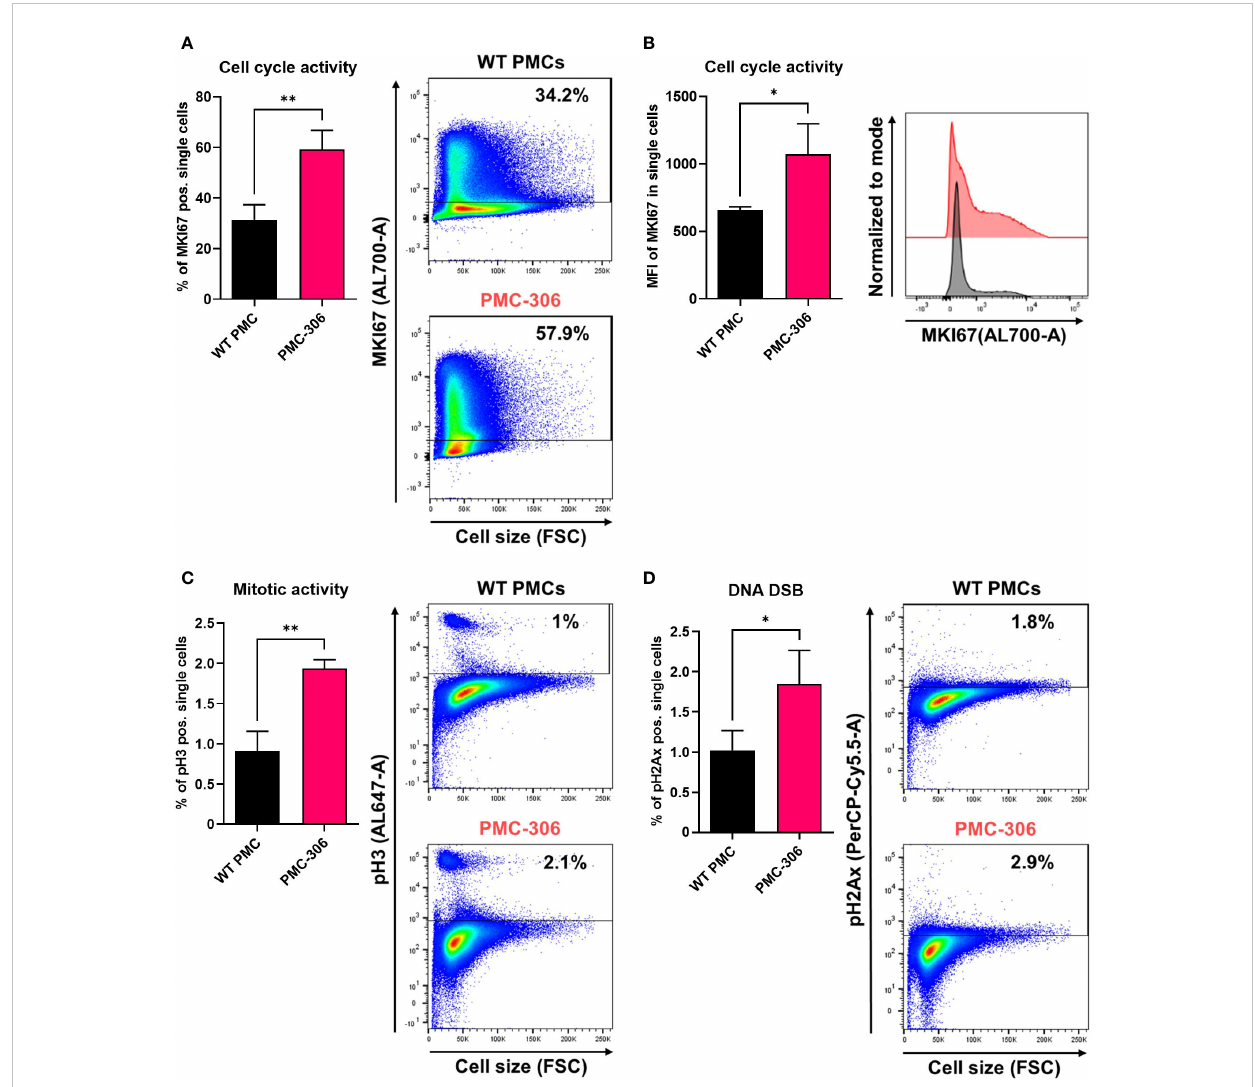
FIGURE 7 PMC-306 cells are characterized by enhanced cell cycle activity and sporadic DNA damage. The cell cycle of primary WT PMCs was compared to PMC-306 cells. (A) Cells were stained with an antibody directed against MKI67 (AL700-A). Left: Quanti fi cation of MKI67+ cells (% of single cells, n=3). Right: Representative FACS-plots of MKI67+ cells (% of single cells, n=3). (B) Quanti fi cation of the mean fl uorescence intensity (MFI, n=3) of MKI67 in single cells (left) and a representative histogram showing MKI67 intensities in primary PMCs and PMC-306 cells. (C) Cells were stained with an antibody directed against phosphorylated histone H3 (pH3, AL647-A). Left: Quanti fi cation of pH3 cells (% of single cells, n=3). Right: Representative FACS-plots of pH3+ cells (% of single cells). (D) Cells were stained with an antibody directed against phosphorylated Histone H2Ax (pH2Ax, PerCP- Cy5.5-A). Left: Quanti fi cation of pH2ax cells (% of single cells, n=3). Right: Representative FACS-plots of pH2Ax+ cells (% of single cells). Data are expressed as mean +SD. Unpaired, two-tailed Student ’ s t test with Welsh ’ s correction. * p <0.05, ** p